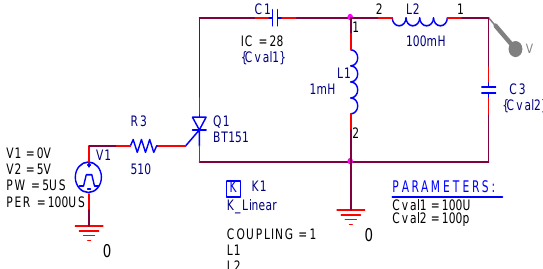
Figure 8. Simulation model of the power supply for laser diode